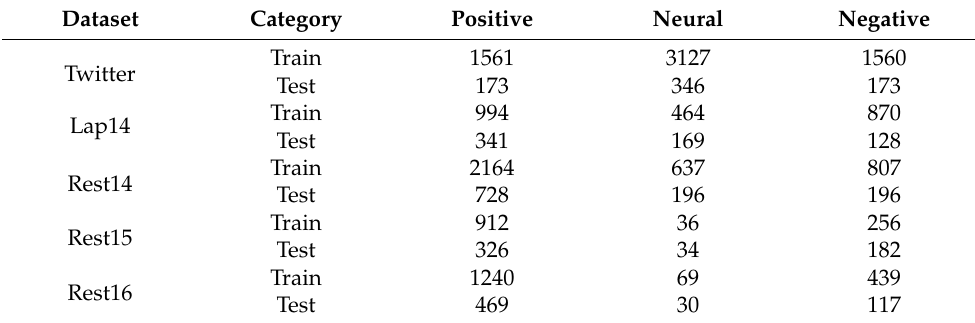
Table 1. Detailed statistical of five datasets in our